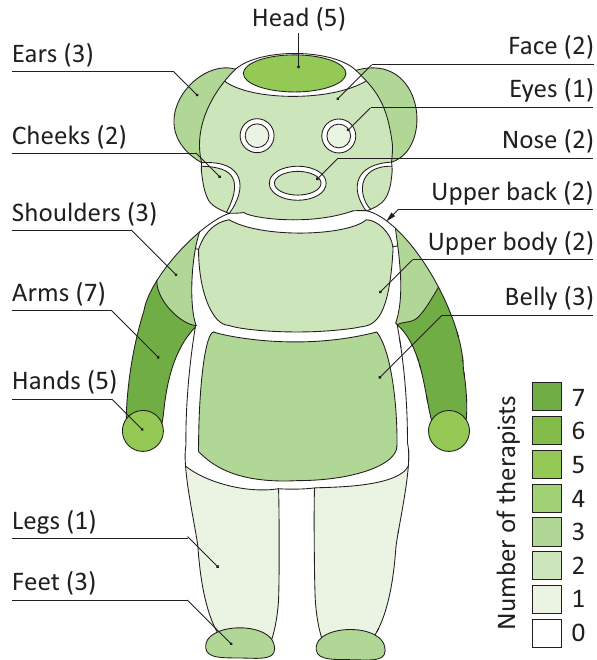
Figure 5: Locations that participants speci fi cally prioritized to equip with touch sensing displayed on a diagram of a generalized robot companion. The number of therapists who suggested each region is shown in parentheses. Most of our 11 participants requested whole - body touch sensing, but they also provided these speci fi c locations in case whole - body sensing is not